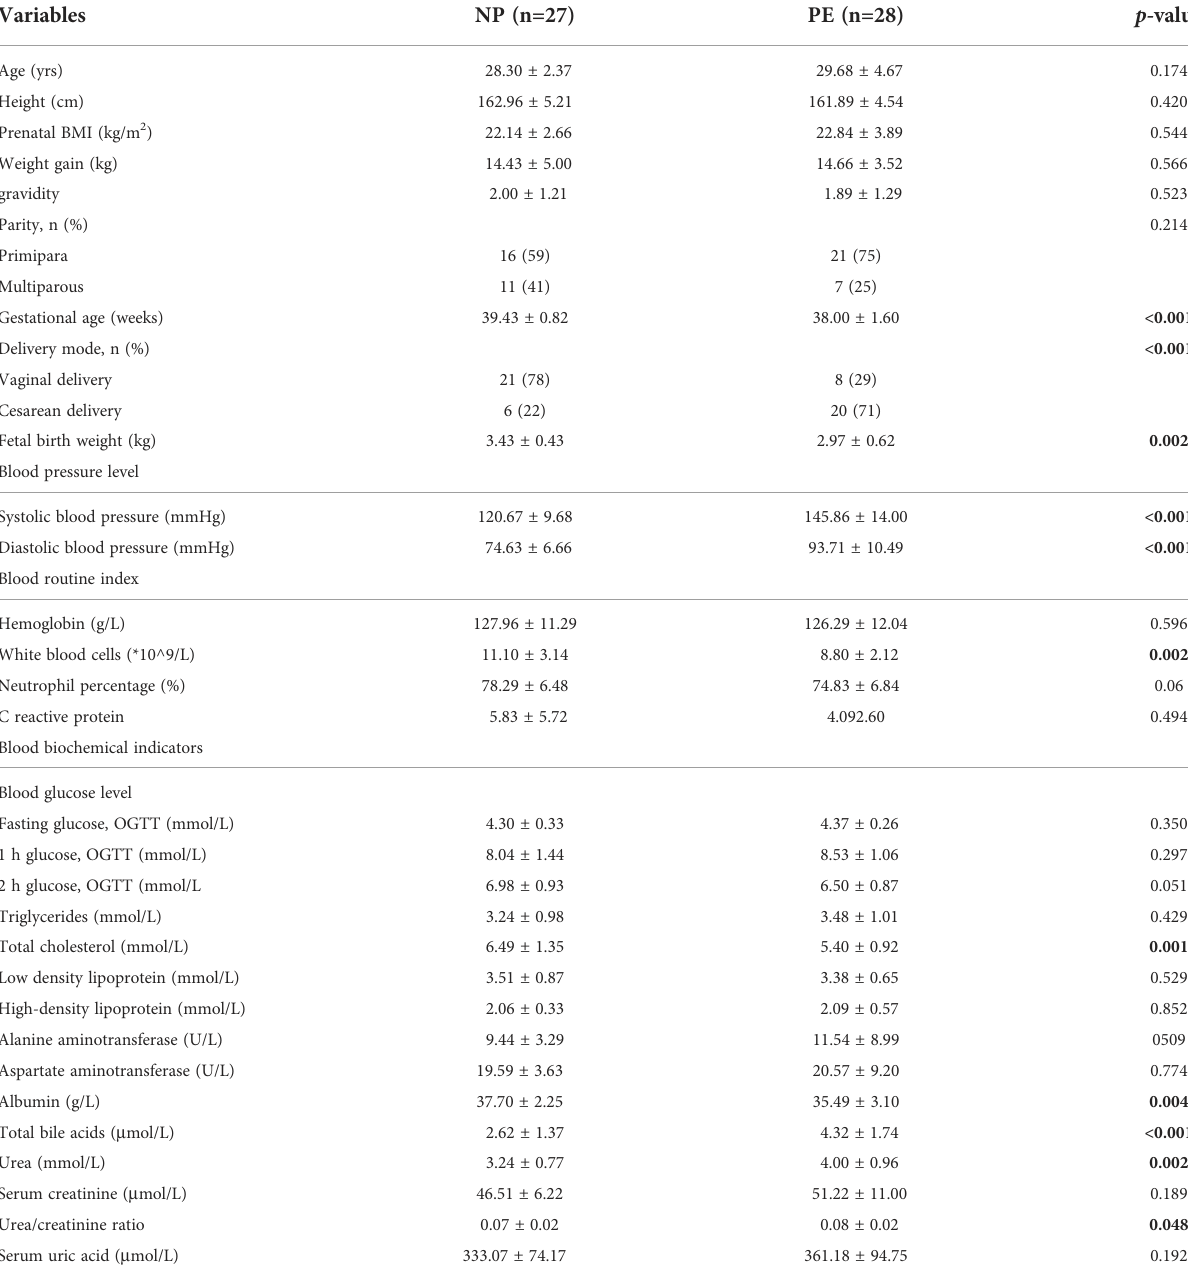
TABLE 2 Maternal and fetal clinical characteristics in the PE and NP